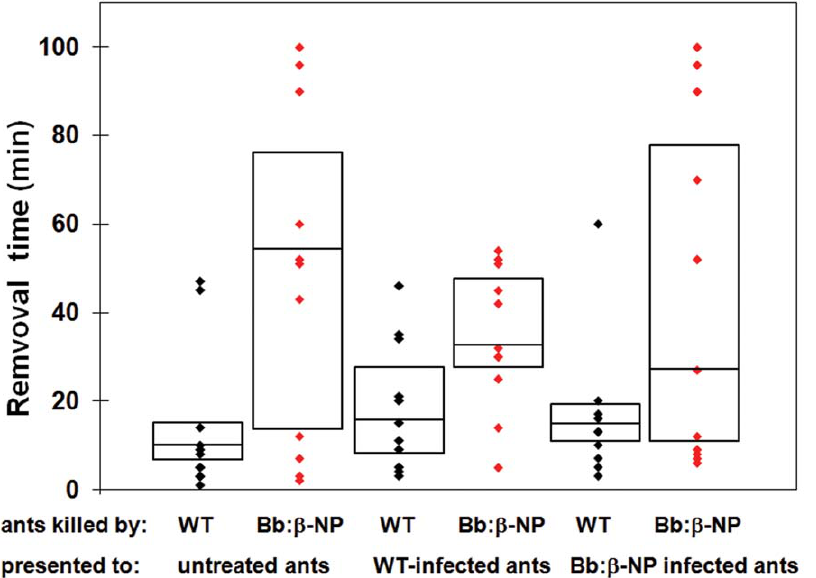
Figure 4. Movement times of WT- or Bb::sp b -NP gpd -killed ants by untreated ants, WT-infected (2 d prior to assay) ants, or Bb::sp b - NP gpd -infected ants. No significant differences were noted between live ants treatments (P=0.86), with WT-killed ants moved significantly faster than Bb::sp b -NP gpd -killed ants regardless of the tested infection state of the ants doing the moving (P , 0.001). This difference was consistent over the live ant treatments (interaction P-value=0.53).